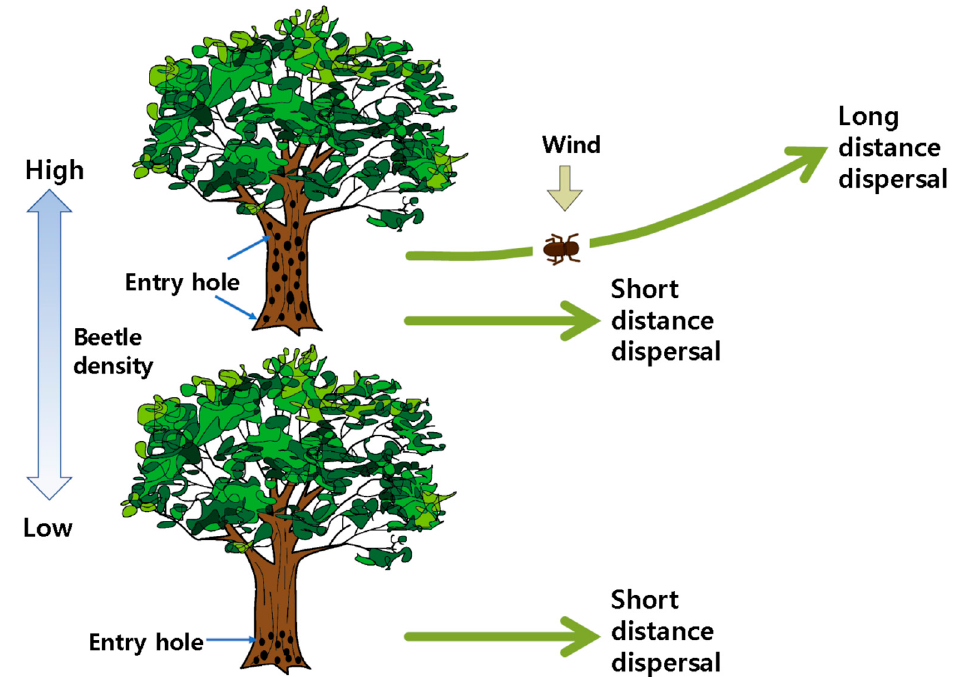
Figure 5. A diagram for hypothesis to explain long distance dispersal of P. koryoensis in density- dependent manner. The diagram was drawn based on a hypothesis suggested by Lee et al. [49] .